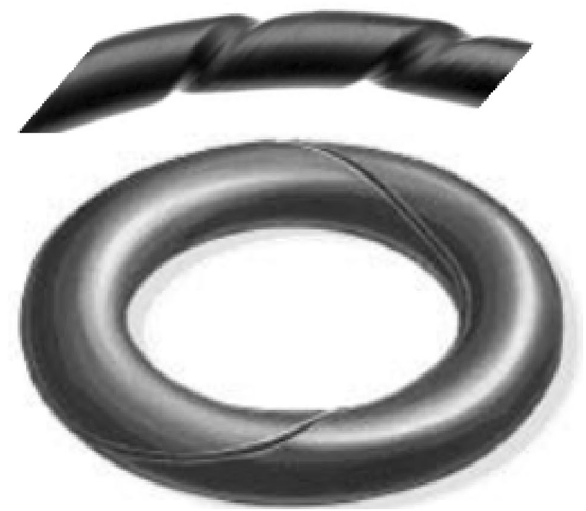
Figure 1. Torsional failure of